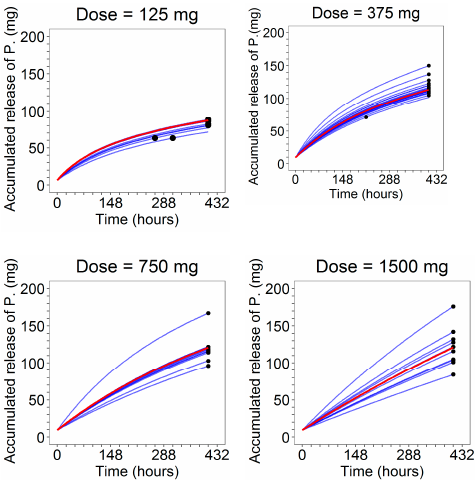
Figure 11. Model predictions of the individual (blue lines) and population (red lines) cumulative release of progesterone together with the observed total amount released at the end of the studies (black dots) stratified on dose level.